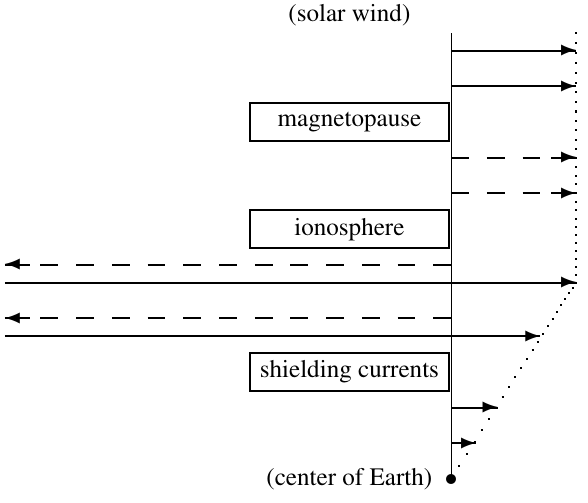
Fig. 3. Total force, calculated from integral of stress tensor over surfaces enclosing varying subvolumes of the Earth-magnetosphere system, separated into mechanical (solid line) and electromagnetic (dashed line) contributions. Arrow to the left (right): force sun- ward (antisunward). The force at each location acts on the enclosed volume, from the location shown down to the center of Earth.